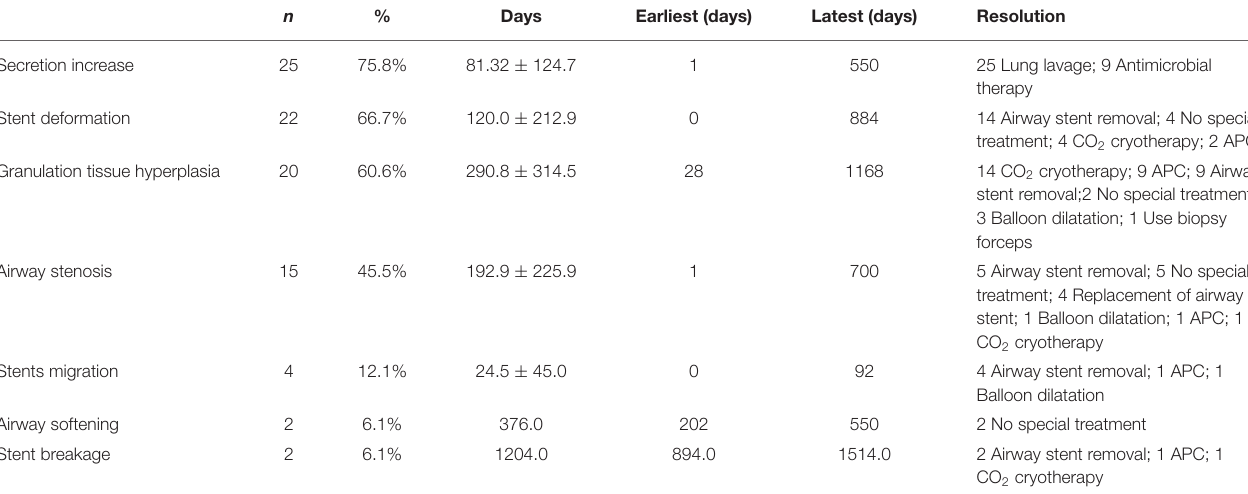
TABLE 6 | Complications and treatment.